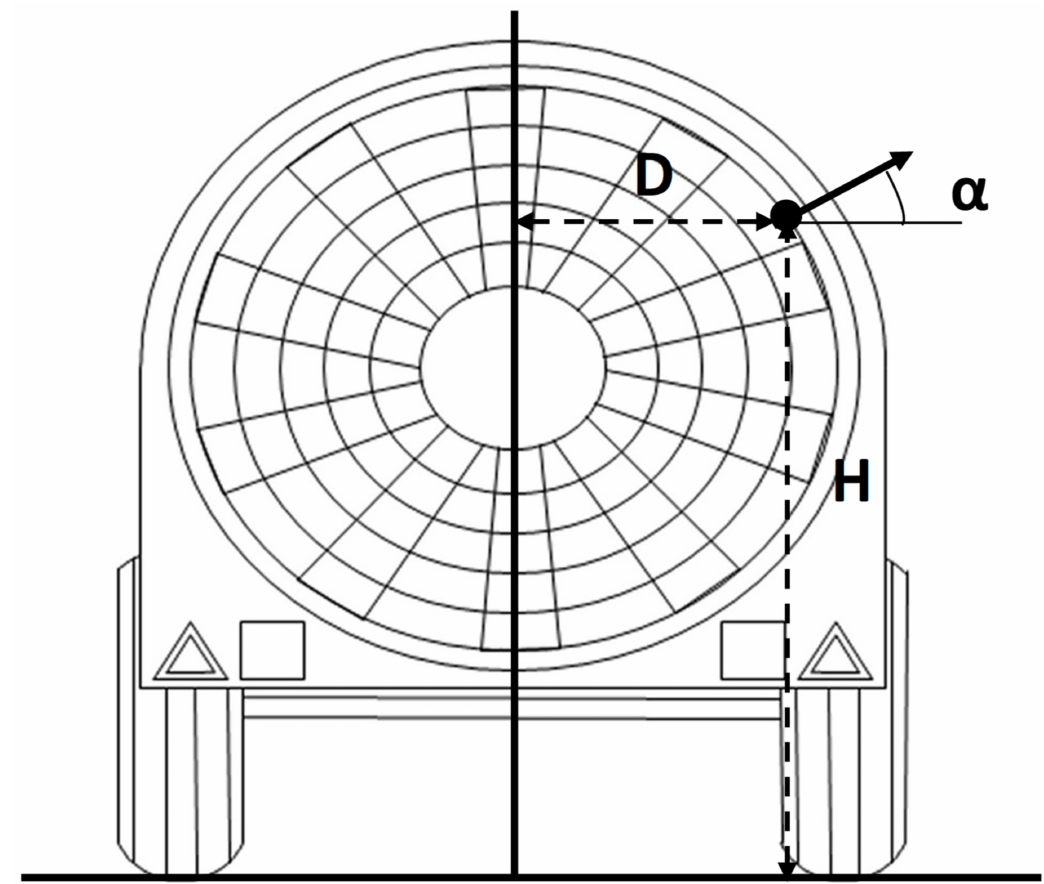
Figure 1. Characterization of the position of the nozzles in both